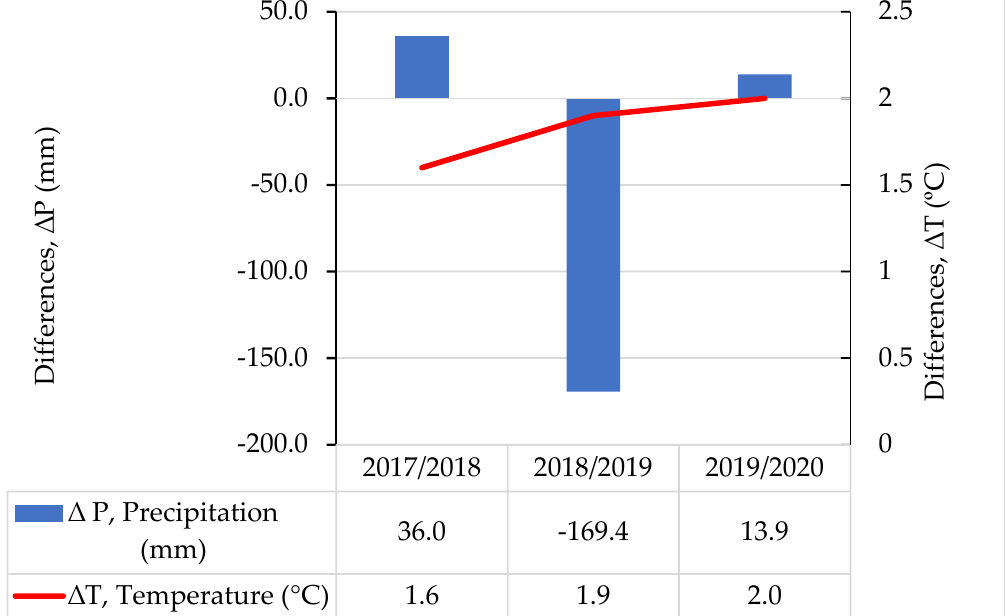
Figure 2. Differences ∆ P (mm) between annual sum of precipitation and long-term (1976–2016) mean annual precipitation (at the value of long-term mean, 631.7 mm, ∆ P = 0). Differences ∆ T (°C) between mean annual air temperature and the long-term (1976–2016) mean annual temperature (at value of long-term mean air temperature = 8.0 °C, ∆ T = 0).